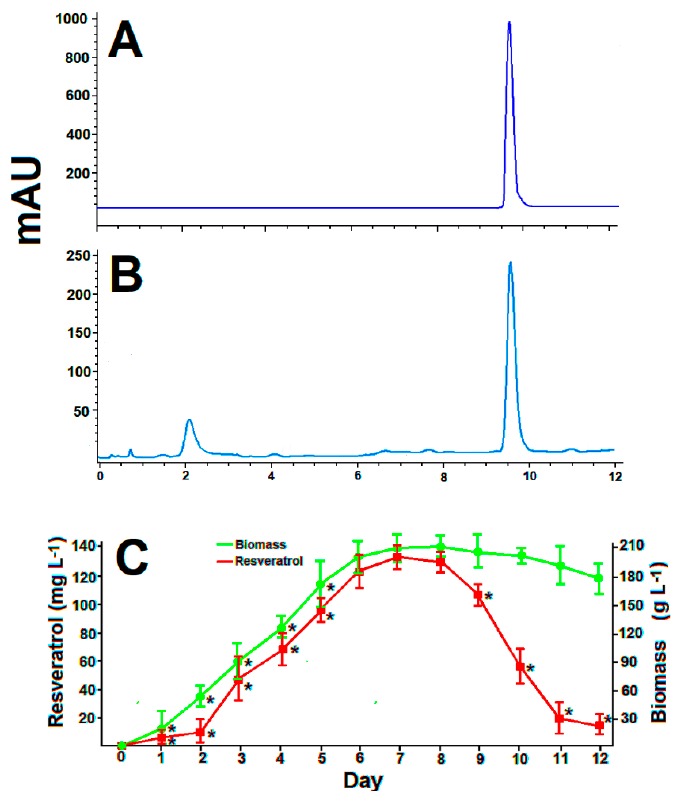
Figure 2. Determination of RV in batch cultures of Arcopilus aureus MaC7A. ( A ) RP − HPLC chro- matogram of pure RV. ( B ) RP − HPLC chromatogram of the RV detected in batch cultures of A. aureus MaC7A. ( C ) Kinetics for the production of RV versus biomass formation at 30 ◦ C and pH 7 in cultures of A. aureus MaC7A. * Indicates days with statically significant differences ( p < 0.05) for RV and biomass production compared with that of day 7. Error bars indicate SD (n = 10).